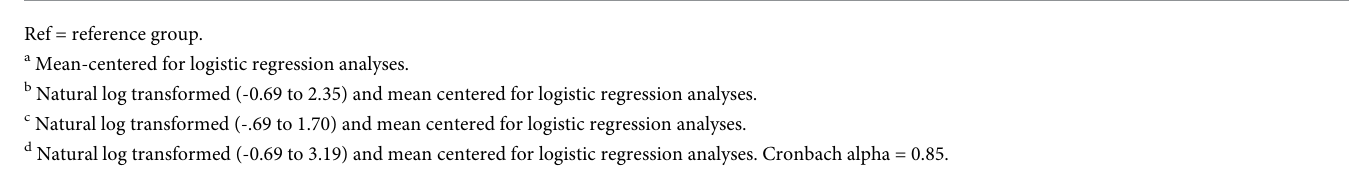
collinearity (Pearson r < 0.80 or Variance Inflation Factor [VIF] < 10), lack of sparseness (i.e., cell counts > 0 and < 20% of cells with expected frequencies < 5 in cross-tabulations between